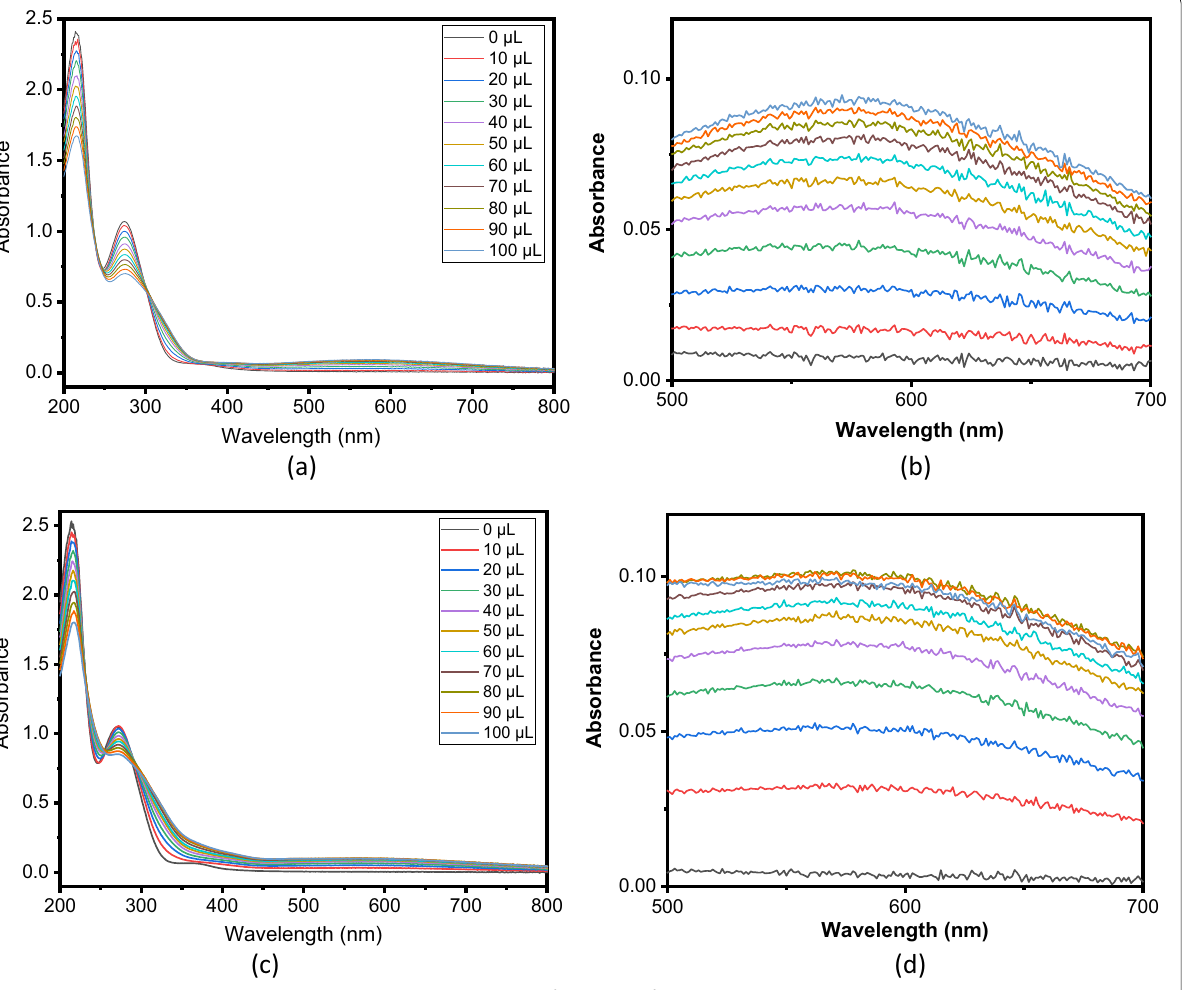
Fig. 3 UV–Vis spectral changes of T. chebula extract titrated with ( a ) Fe 2 + and ( c ) Fe 3 + . b and d are the enlarged part of the graph (500–700 nm range) of Fe 2 + and Fe 3 +